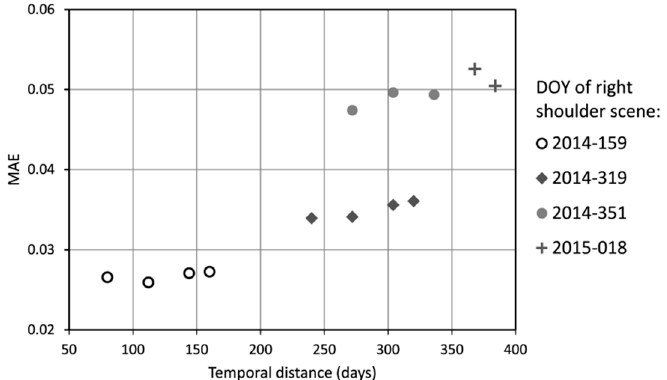
Figure 12. Relationship between the mean absolute error (MAE) and the temporal distance between the shoulder scene combinations (SSC). The MAE was calculated by using all possible SSC for predicting the Landsat scene (195/52) acquired on DOY 143, 2014, and the MAE was derived between predicted scenes and observed scene. The different symbols represent different acquisition dates of the right shoulder scene, e.g., the four diamond symbols represent four predictions of DOY 143 with the same right shoulder (DOY 319) but different left shoulders.